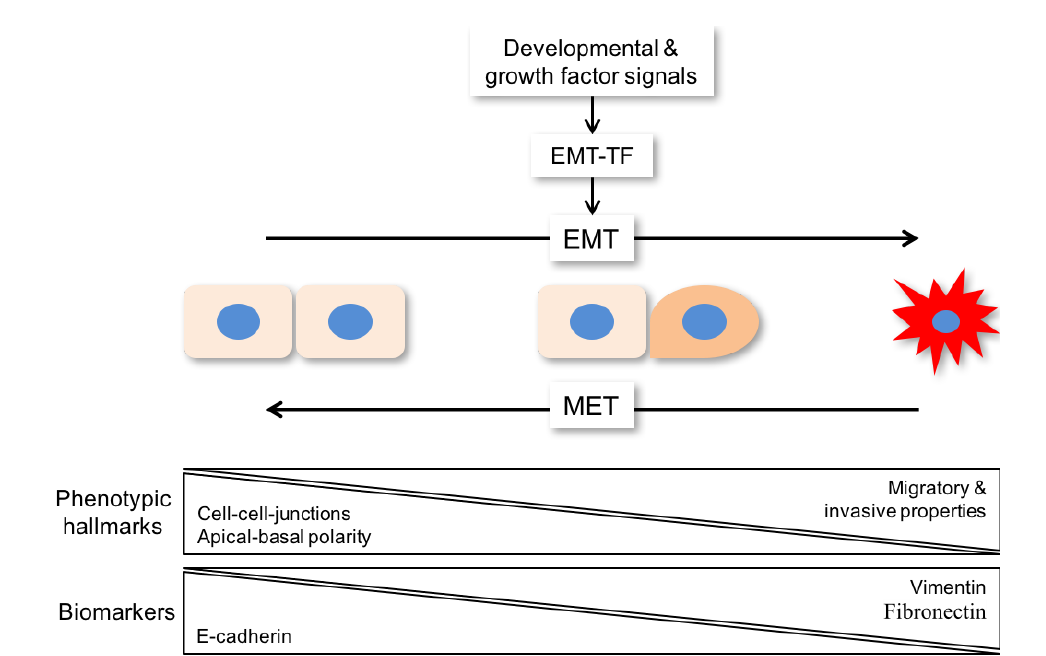
Figure 1. Scheme of EMT (epithelial-to-mesenchymal transition) as a program with dynamic transitional states, which are characterized by metastable intermediates. For metastatic colonization, a reversal of EMT known as mesenchymal-to-epithelial transition (MET) supports tumor cell expansion as an important prerequisite for metastatic growth. Phenotypic hallmarks of EMT are loss of cell-cell junctions, loss of apical–basal polarity, and acquisition of migratory and invasive properties. Those changes are induced by loss of E-cadherin and increased levels of biomarkers like vimentin and fibronectin. EMT-TF: EMT-transcription factor.